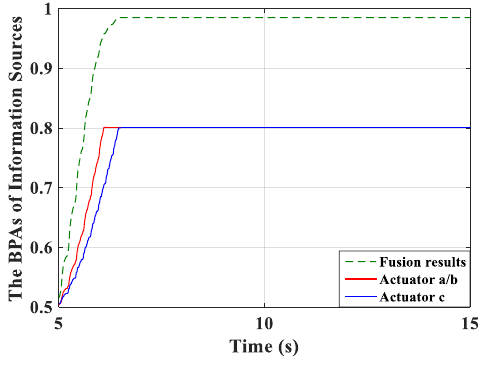
Figure 22. The BPAs curves. Figure 22. The BPAs